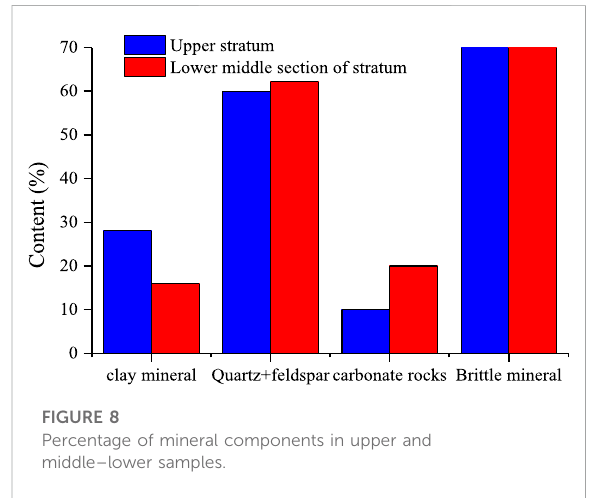
FIGURE 8 Percentage of mineral components in upper and middle – lower samples.